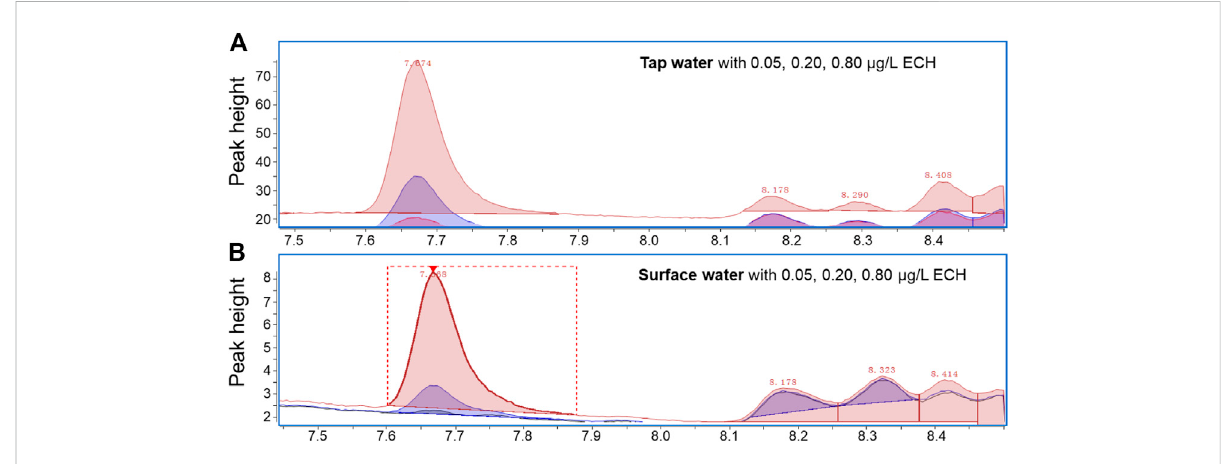
FIGURE 4 Chromatogram (EIC, m/z = 57) from GC/MS analysis of ECH standard solutions added in (A) tap water and (B) surface water.